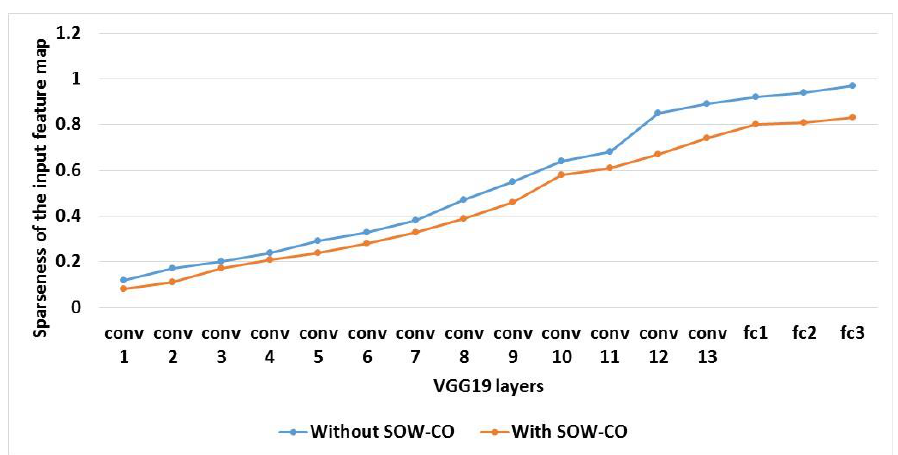
Figure 19. Graphical illustration of IFM’s sparseness for VGG19.